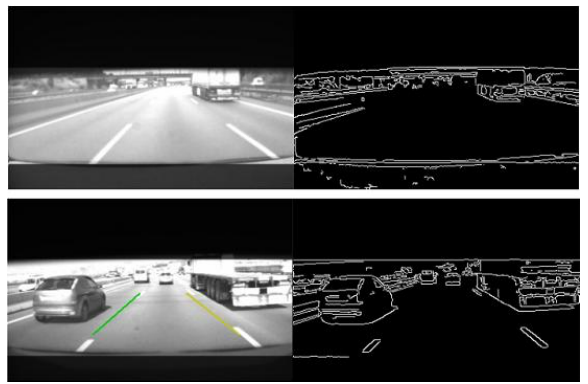
Figure 5. Canny images after adaptive thresholding.